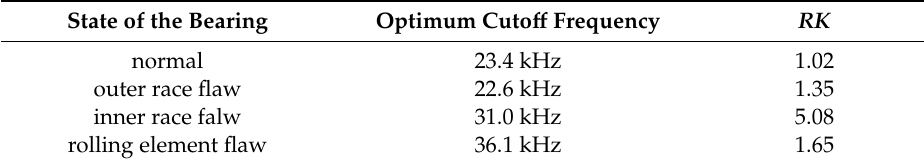
Table 1. Optimum cuto ff frequency and kurtosis ratio (RK) of CH3 (learning phase). State of the Bearing Optimum Cuto ff